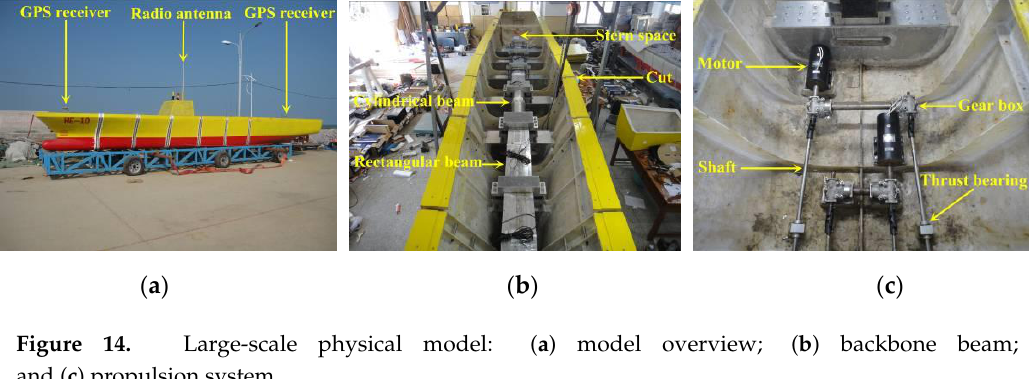
Figure 14. Large-scale physical model: ( a ) model overview; ( b ) backbone beam; and ( c ) propulsion system.